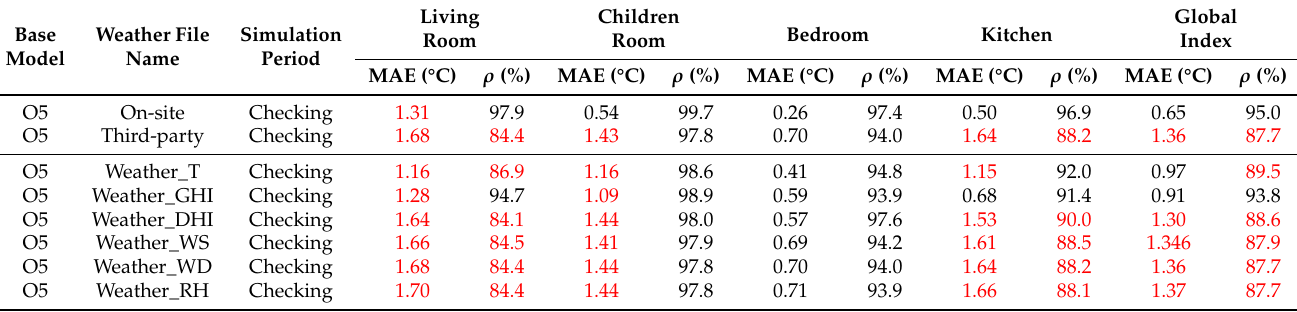
Table A6. MAE and ρ indices per thermal zone in the checking period. House O5, base